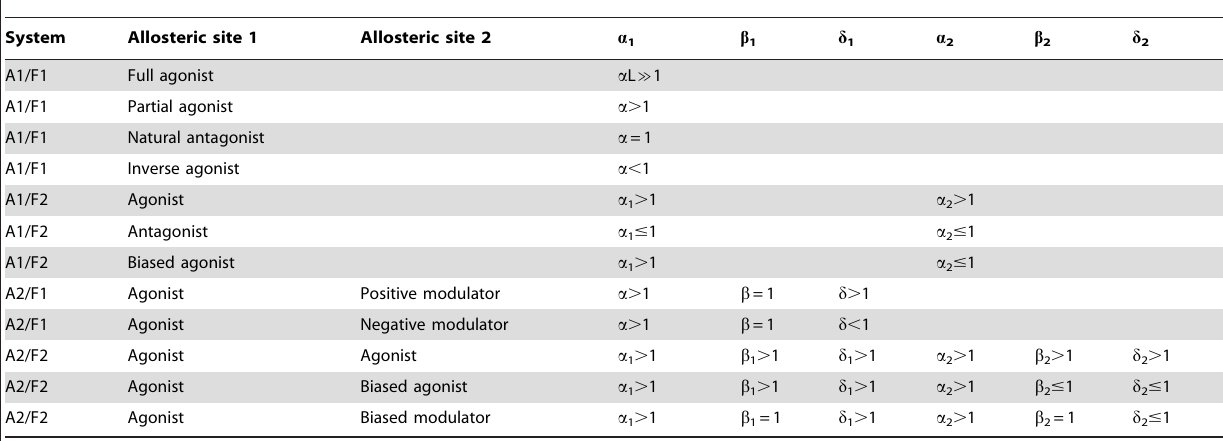
Table 1. Agonist classification by the simplified structural view of